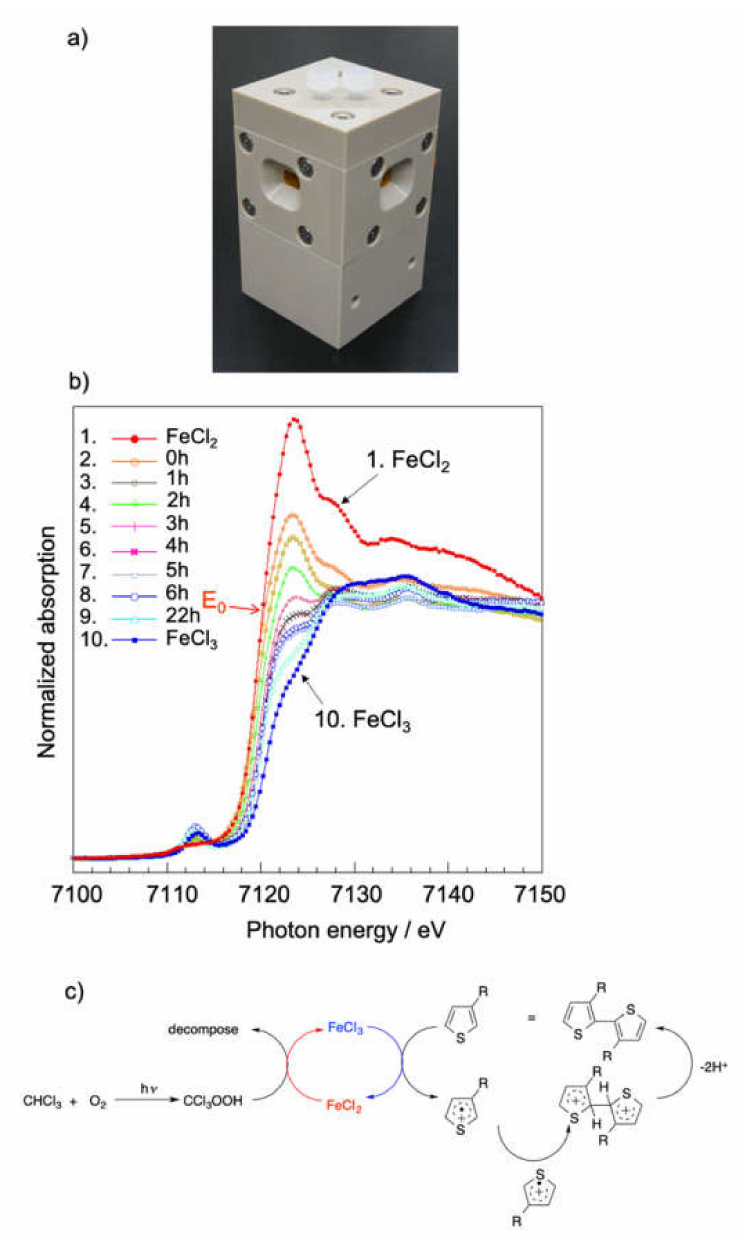
Figure 8. ( a ) Homemade cell for XAFS measurements. ( b ) XANES spectra of the polymerization of 3HT with FeCl 3 in CHCl 3 . ( c ) Reaction mechanism of oxidative coupling polymerization of 3HT. Reproduced with permission [34]. 2015, John